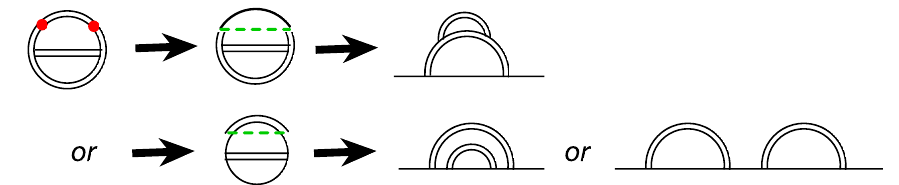
Figure 18 . An example showing how to generate dominant contributions to the quark 2-point functions. We start with a mesonic vacuum graph and insert two vertices, shown in red. In this (cid:12)gure the two vertices sit on the same meson propagator, but this needn’t be the case in general. We then \unzip" the mesons between these vertices. This can be done in two ways. In the top panel we unzip the \short" way and in the bottom panel we unzip the \long" way. In the latter case, as discussed in the text, the unzipping passes straight through the two vertices. Finally we obtain various dominant contributions to the quark 2-point function by cutting open the various quark lines that have been exposed.